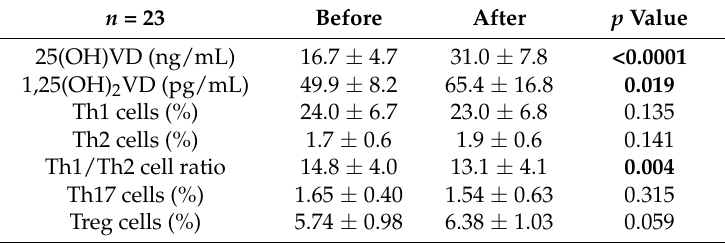
Values are average ± standard deviation. 25(OH)VD, 25 hydroxyvitamin D 3 ; 1,25(OH) 2 VDl 1,25 dihydroxyvitamin D 3 ; Th1 cell, interferon [IFN]- γ -producing T-helper cell (CD4 + /IFN- γ + /interleukin[IL]-4 − ); Th2 cell, IL-4-producing T-helper cell (CD4 + /IFN- γ - /IL-4 + ); Th17 cell, IL-17- producing T-helper cell (CD4 + /IL-17 + ); Reguratory T [Treg] cell, CD4 + /CD25 + /FoxP3 T-helper cell. 1,25(OH)2VD, Th17 cells, and Treg cells were measured in eight patients.